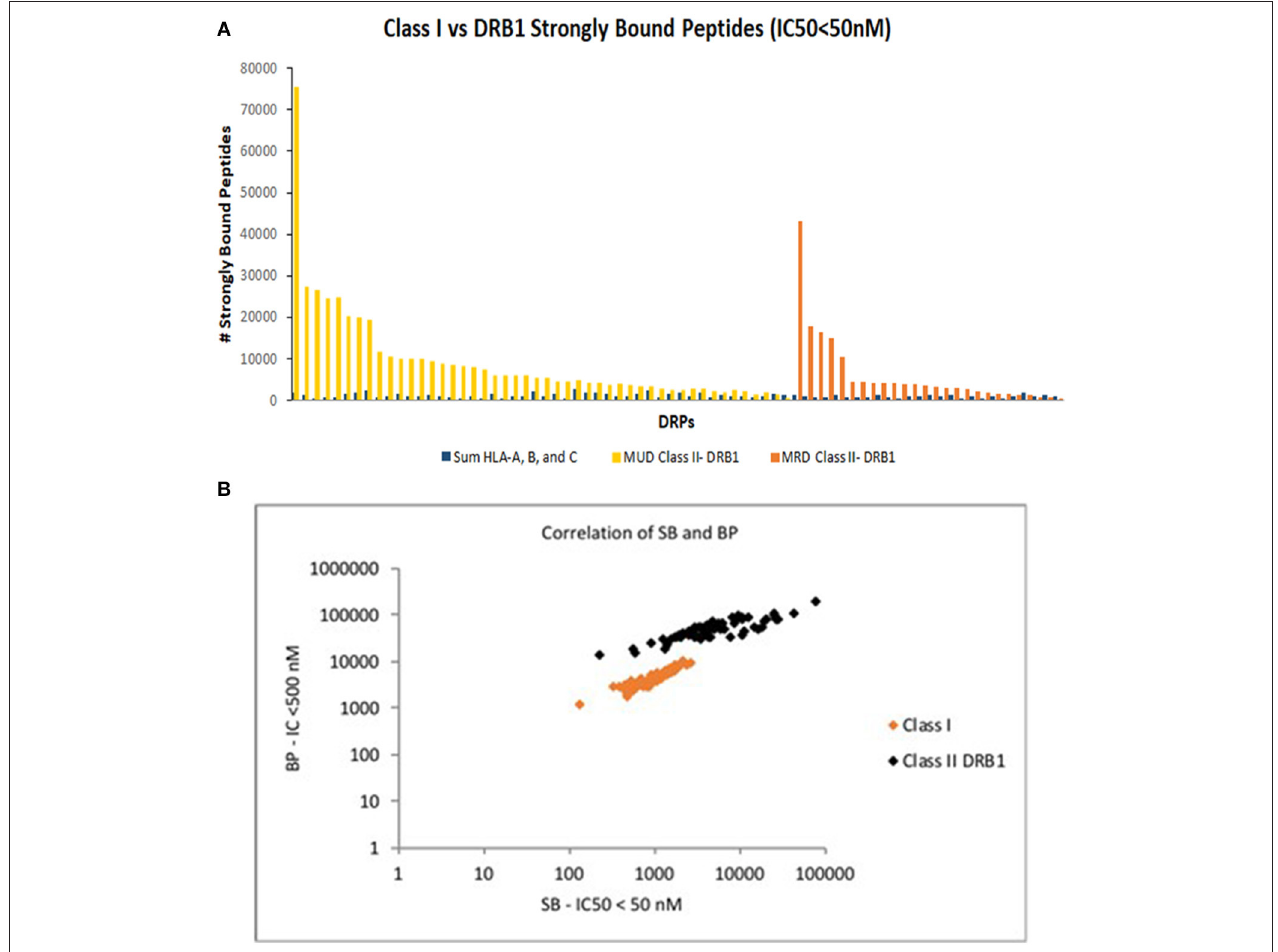
FIGURE 3 | Comparison of HLA class I & class II bound peptides in HLA MRD and MUD DRP. Depicting SB peptides on standard scale in descending order and differentiated by donor type (A) . (B) Correlation of SB and BP for both HLA class I and class II molecules in MRD and MUD